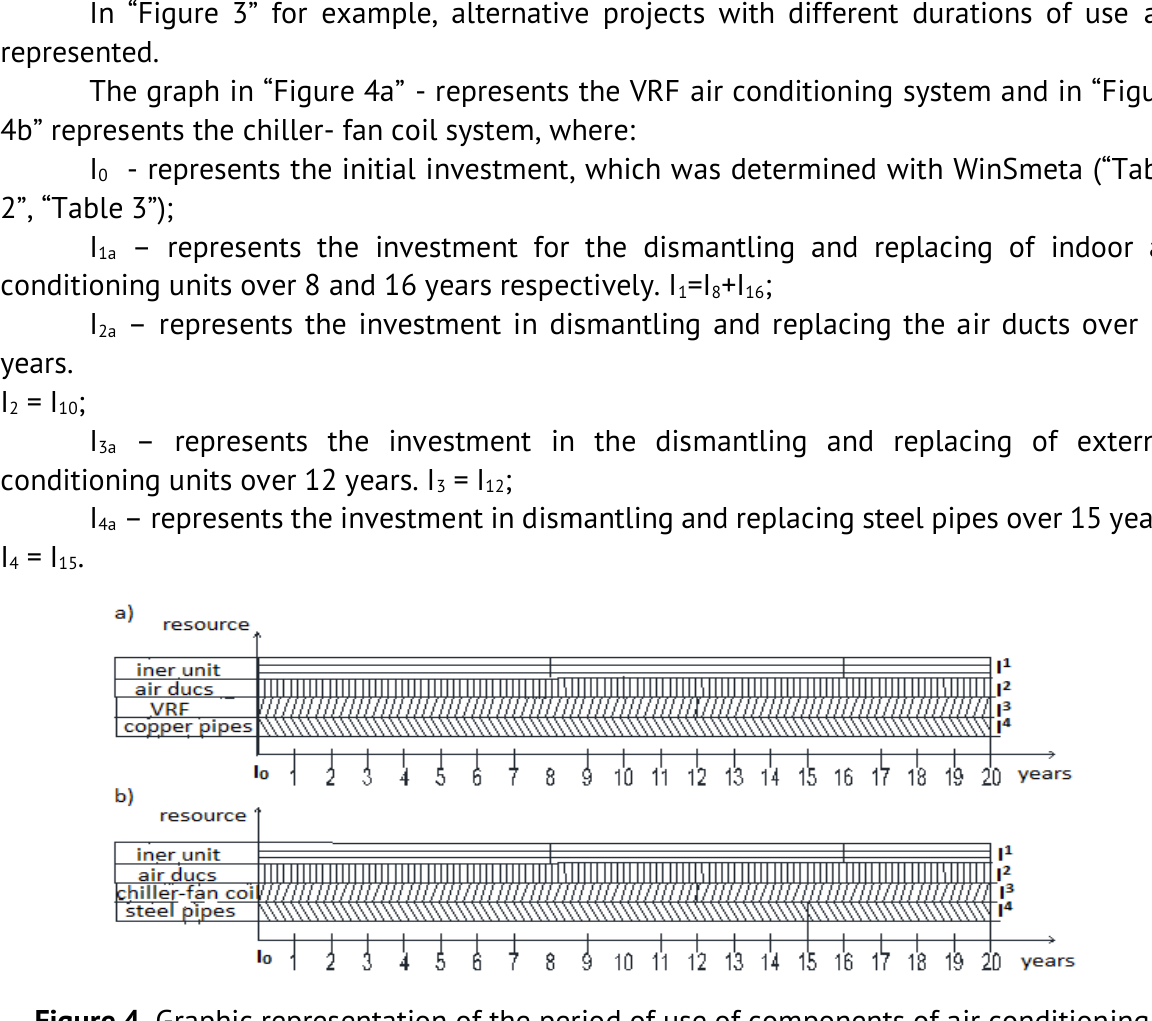
Figure 4. Graphic representation of the period of use of components of air conditioning